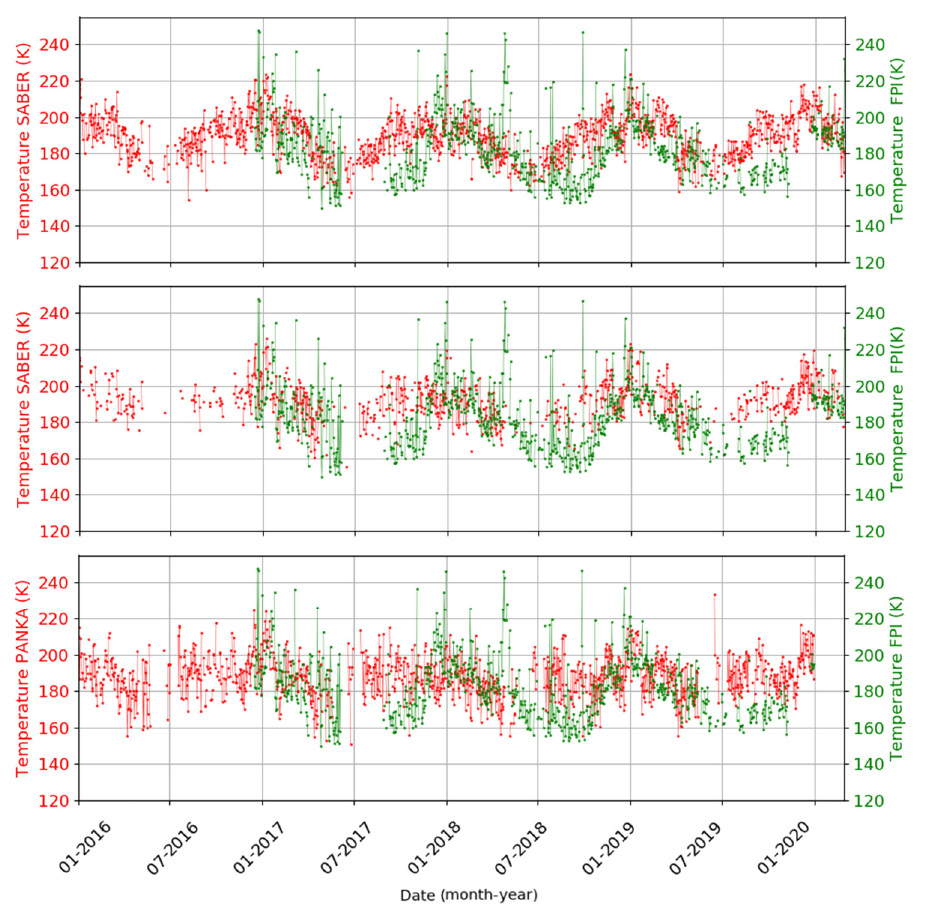
Figure 11. Dynamics of the temperature observed with Fabry–Pérot interferometer (green), and dynamics of the effective temperature calculated from SABER data (red) with the shift in the height of the intensity profile in 2016–2020 above GPO in Tory, nighttime. The top panel presents data calculated using [20], the middle panel presents data calculated using [24], and the bottom panel presents data calculated using [25].